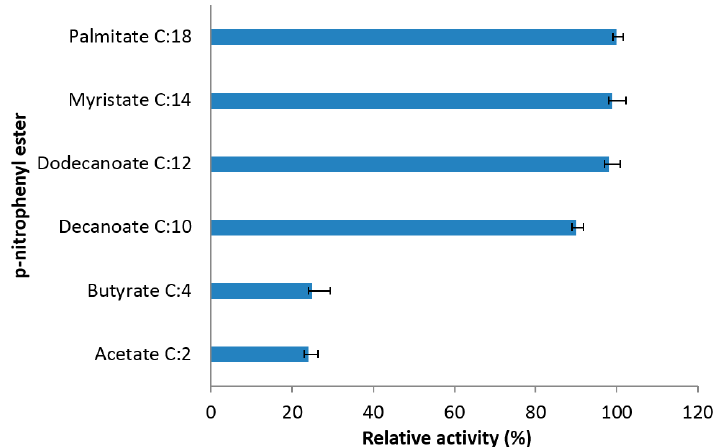
Figure 10. Substrate specificity of purified truncated AMS3 lipase towards p -nitrophenyl ester. The data shown are means of triplicate measurements expressed as% activity relative to those of palmitate.